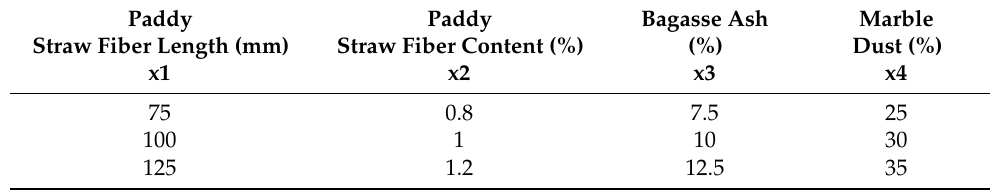
Table 4. Design mix using marble dust, paddy straw fiber, and bagasse ash in soil